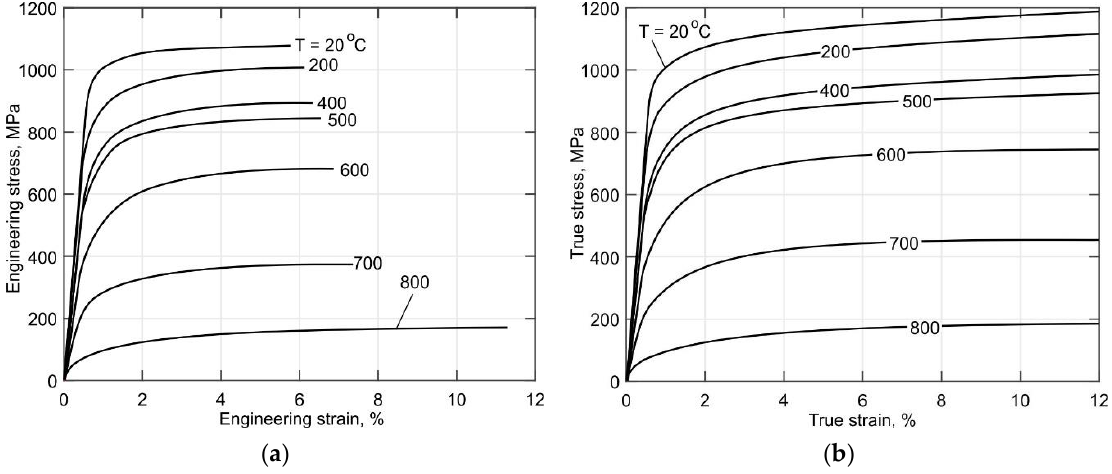
Figure 10. ( a ) Engineering and ( b ) true tensile curves of the DLD-processed Ti-6Al-4V alloy.